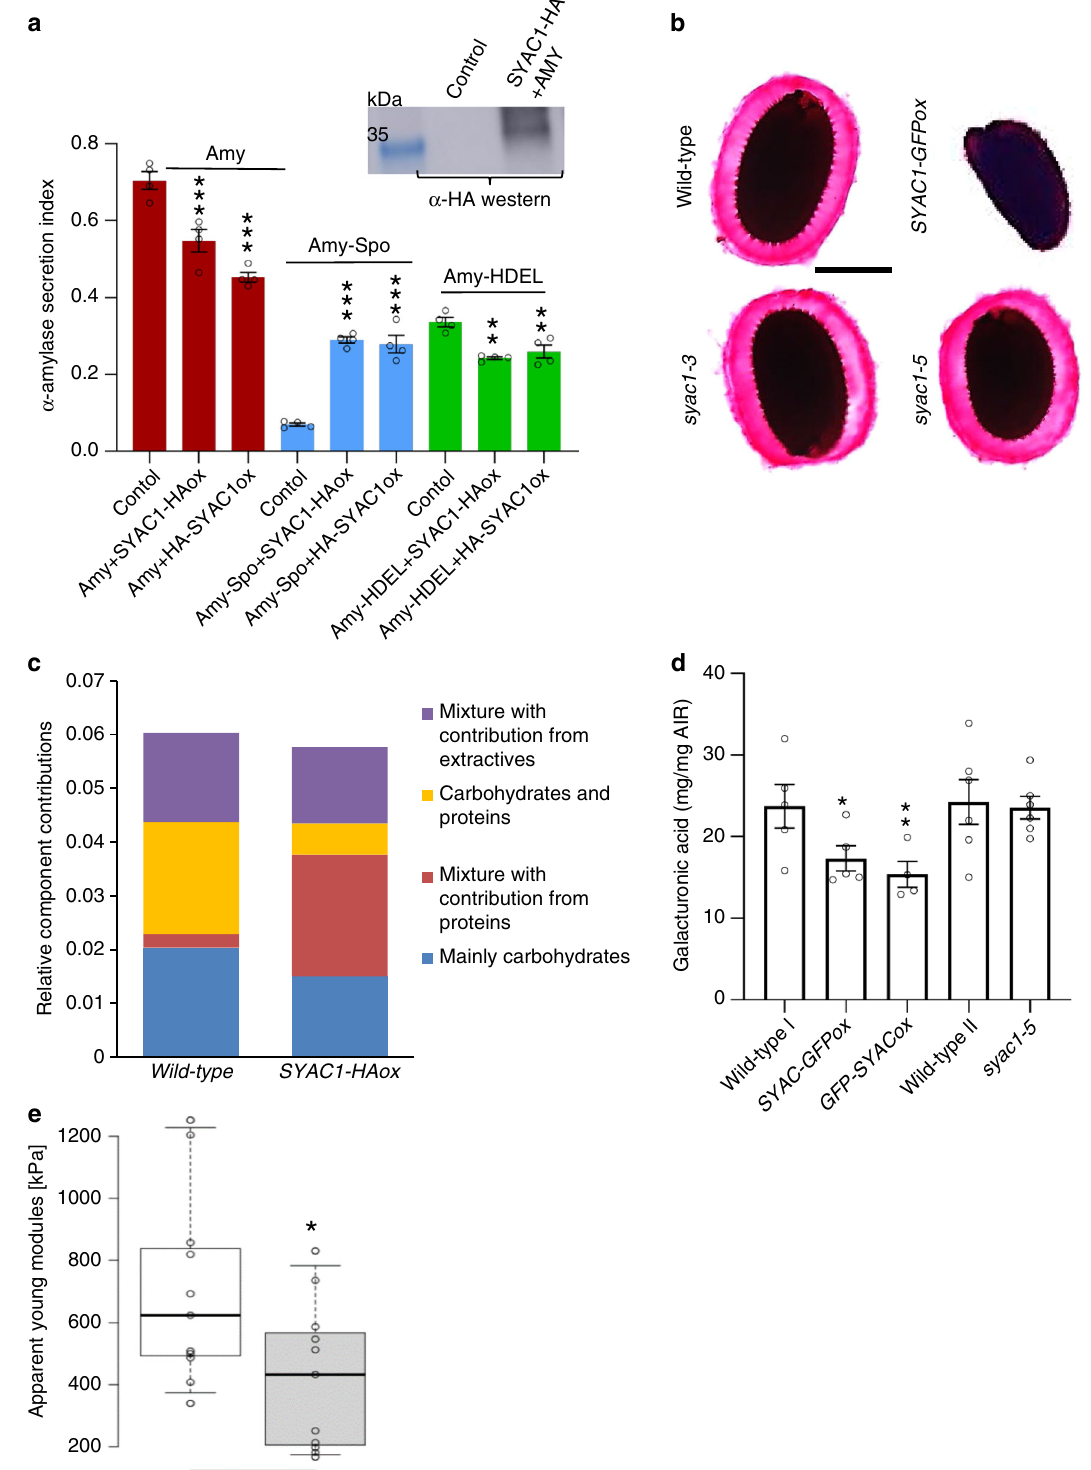
with YIPs and Echidna proteins, a previously found regulatory components of secretory pathway 35 , motivated us to explore the role of SYAC1 in the control of soluble cell wall polysaccharides (pectin and hemicellulose) secretion. Investigating the seed coat epidermis, whose TGN is highly specialized for pectic